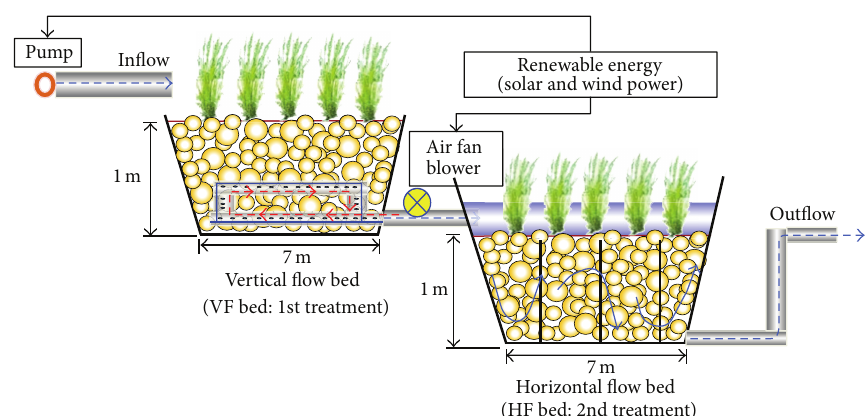
Figure 2: Diagrams of a VF-HF hybrid constructed wetland with ventilation using ventilation pipe and an electric air fan blower by renewable energy of solar and wind power for treating sewage.